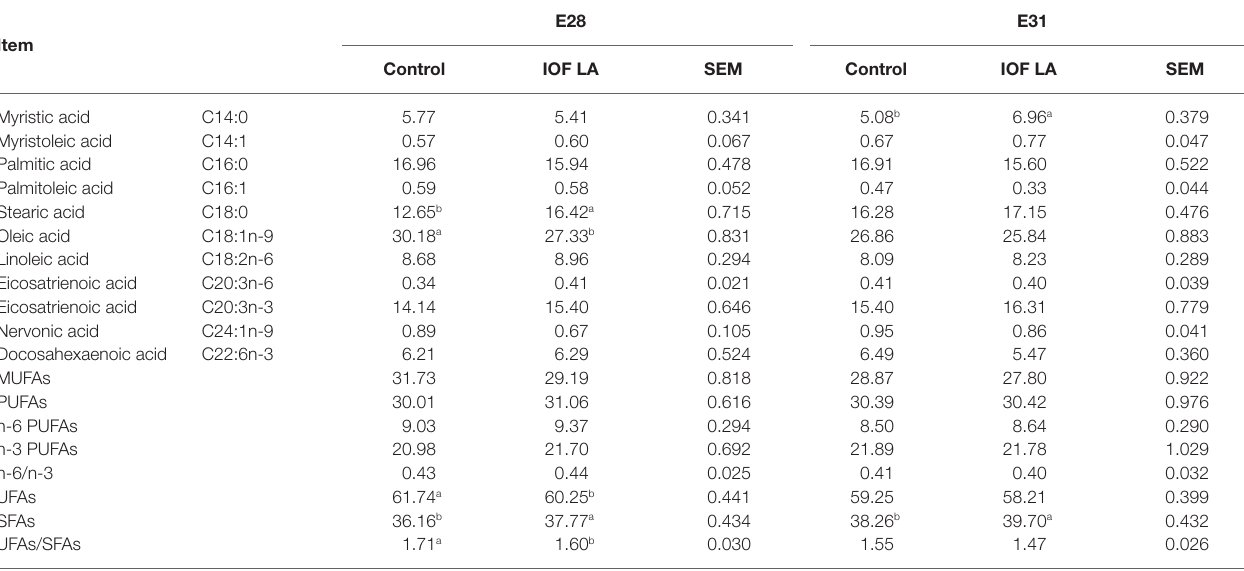
TABLE 2 | Effect of in ovo feeding linoleic acid on the changes of hepatic fatty acid composition in the avian model